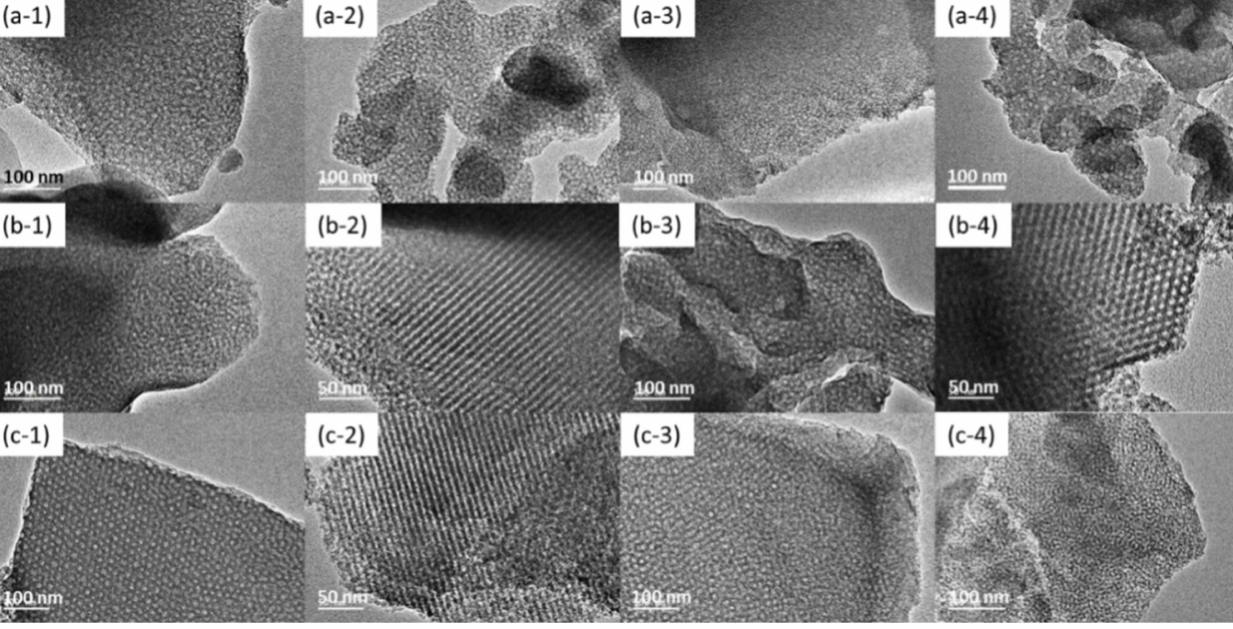
Figure 2. TEM images of mesoporous organosilica samples: PMOF-1 ( a-1 ), PMOF-2 ( a-2 ), PMOF-3 ( a-3 ), PMOF-4 ( a-4 ), PMOA-1 ( b-1 ), PMOA-2 ( b-2 ), PMOA-3 ( b-3 ), PMOA-4 ( b-4 ), PMOB-1 ( c-1 ), PMOB-2 ( c-2 ), PMOB-3 ( c-3 ), PMOB-4 ( c-4